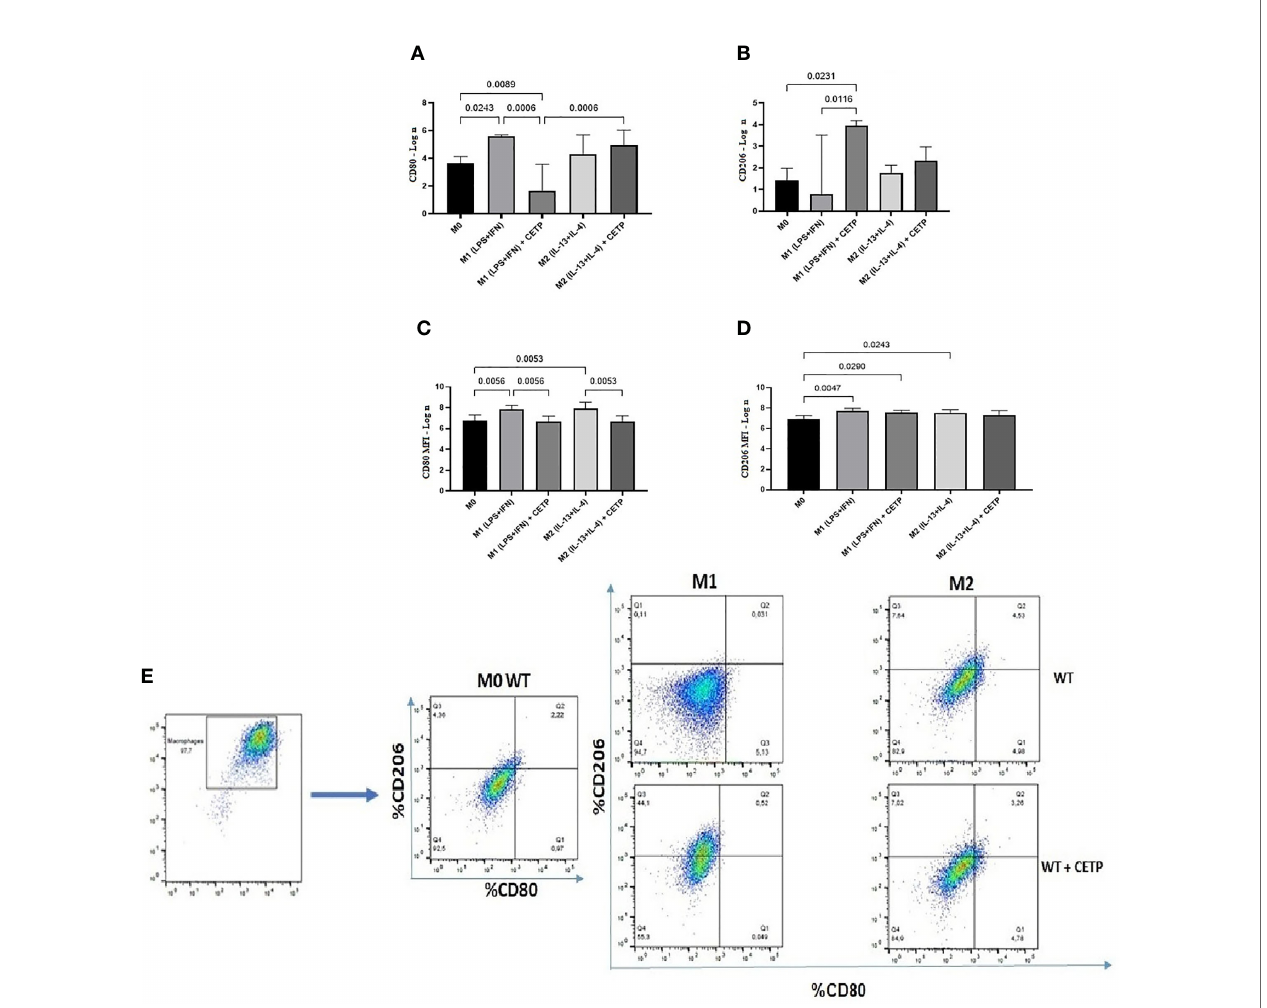
FIGURE 7 | Expression of cell surface markers associated with M1 (CD80) and M2 (CD206) from bone marrow-derived macrophages of WT mice in the presence of recombinant CETP. Expression of CD80 (A) , CD206 (B) , mean fl uorescence intensity (MFI) of CD80 (C) , MFI of CD206 (D) , and representation of the gate strategy (E) . Non-stimulated control cells (M0), stimulated M1 (5 ng/ml of IFN g + 50 ng/ml of LPS) or M2 (10 ng/ml of IL-13 + IL-4) for 24 h. Basal fl uorescence was determined using unlabeled cells, and compensation was performed with cells labeled with the respective fl uorochromes on the FACSCanto II cytometer. In total, 100,000 events were analyzed. Values were expressed as mean and standard deviation. These data were analyzed by ANOVA with two-stage linear step-up procedure of Benjamini, Krieger, and Yekutieli post-test; (n = 3). P < 0.05.